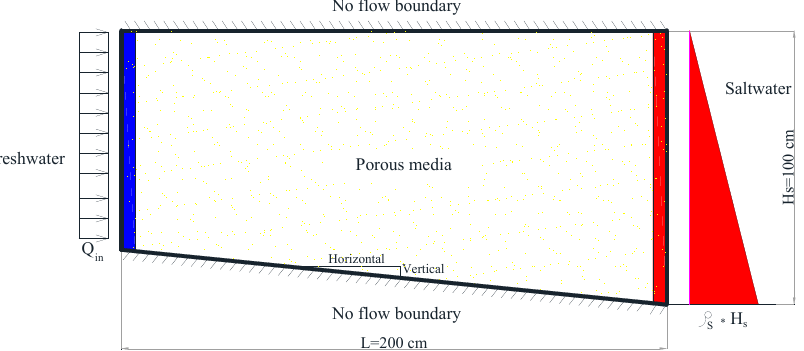
Figure 5. Relationship between seaside slope and intrusion length (X T ). Figure 6. Schematic sketch of bed slopes of 20:1 and 10:1 toward the land .